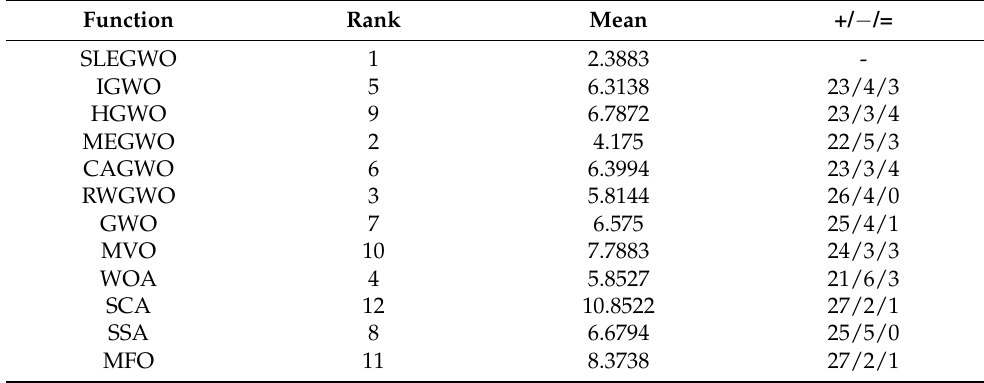
Table 2. Comparison results of SLEGWO with 10 other competitors on classical